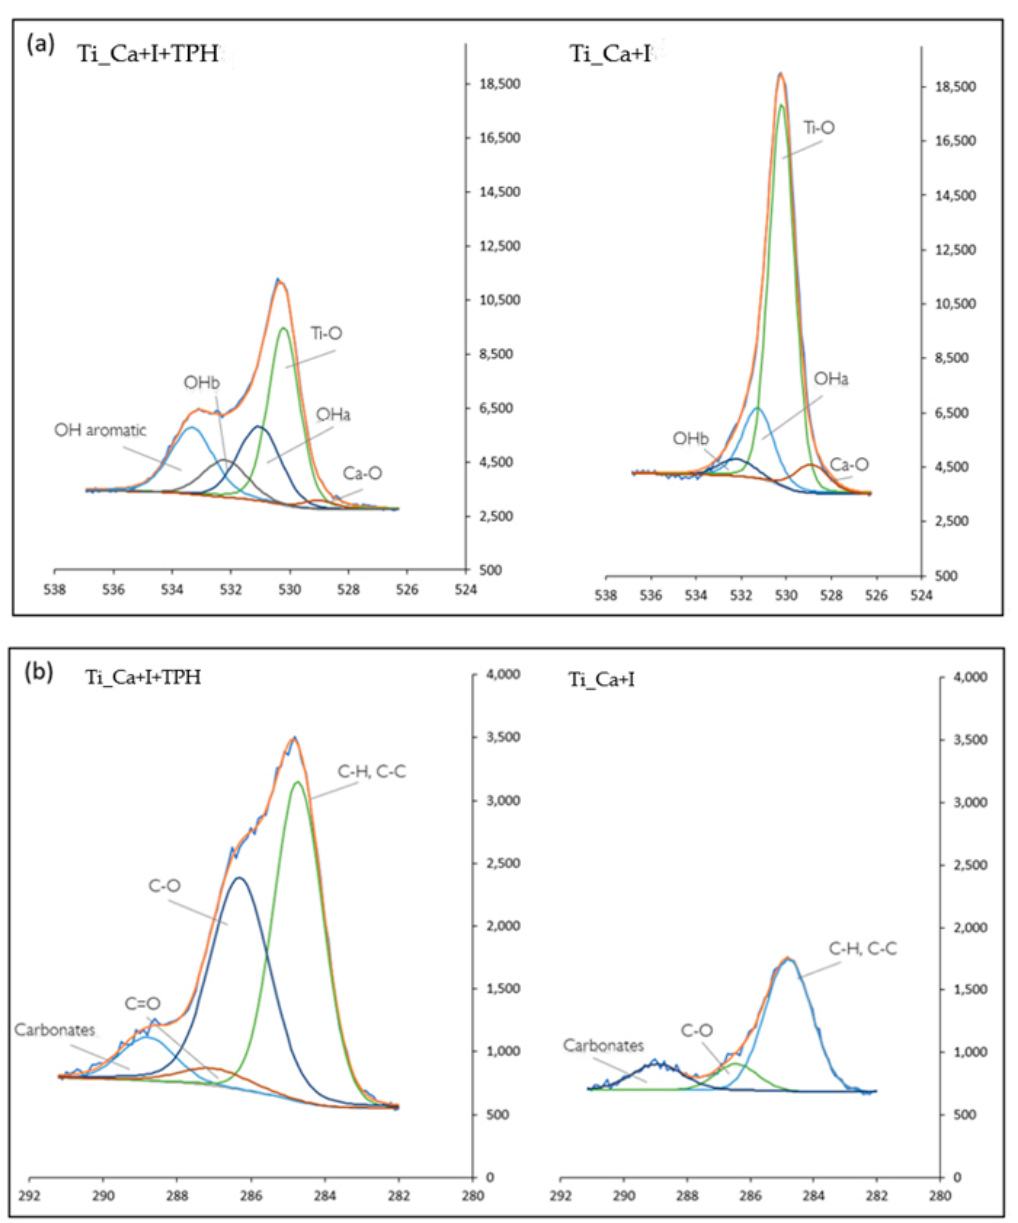
Figure 2. XPS high resolution (HR) spectra of ( a ) O1s and ( b ) C1s of the samples Ti_Ca+I+TPH and